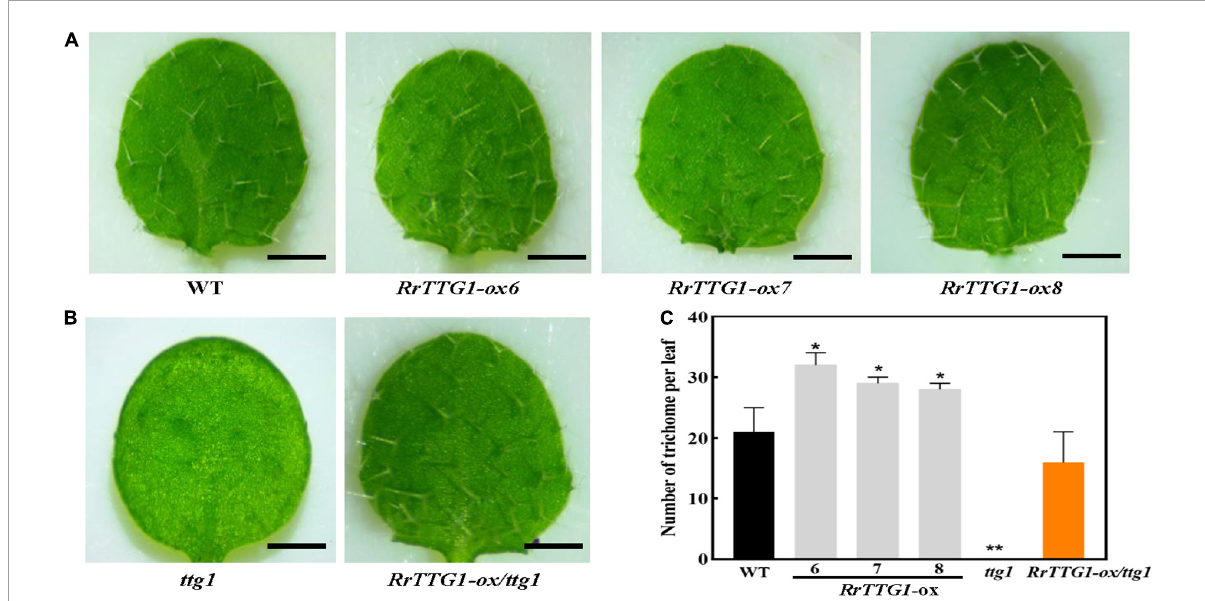
FIGURE5 RrTTG1 promoted trichome formation in Arabidopsis. (A) Ectopic expression of RrTTG1 could increase the trichome number in Arabidopsis . Leaf trichome phenotypes from the first two rosette leaves of 1-week-old soil-grown seedlings of the WT (Col-0) and three RrTTG1-ox transgenic plants were compared, bar = 1 cm. (B) RrTTG1 complemented the glabrous phenotype of ttg1 mutant. Leaf trichome phenotypes from the first two rosette leaves of one-week-old soil-grown seedlings of the ttg1 and three RrTTG1 -ox /ttg1 transgenic plants were compared, bar = 1 cm. (C) Comparison of the trichome number per leaf in the WT, ttg1 mutant, and transgenic plants ( RrTTG1 -ox and RrTTG1 -ox/ ttg1 ). Values are means ± SD ( n = 30) and analyzed using one-way ANOVA (** p < 0.01, * p <